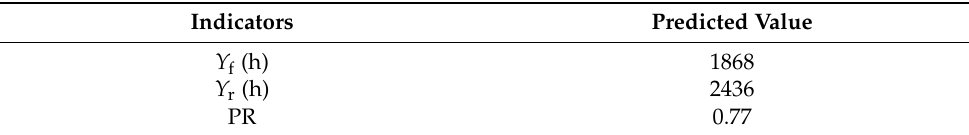
Table 4. Predicted values of the